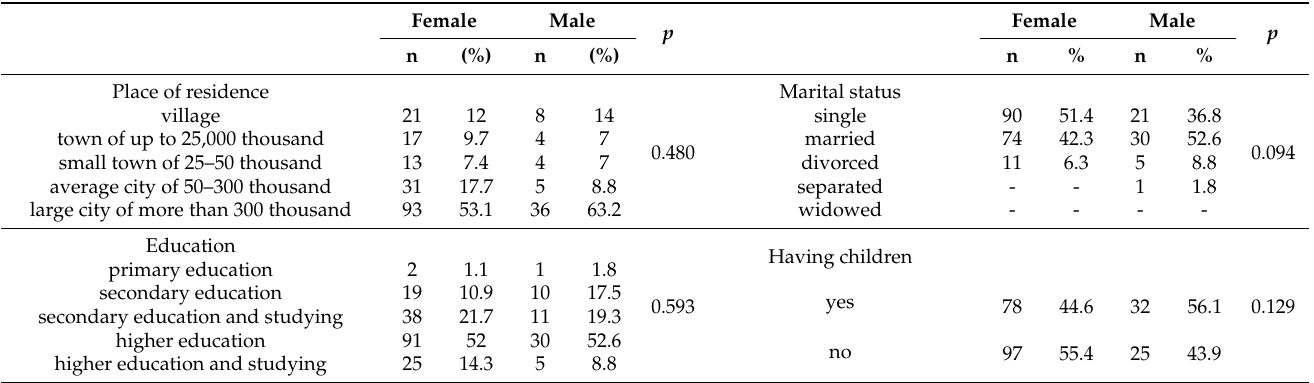
Table 1. Basic sociodemographic